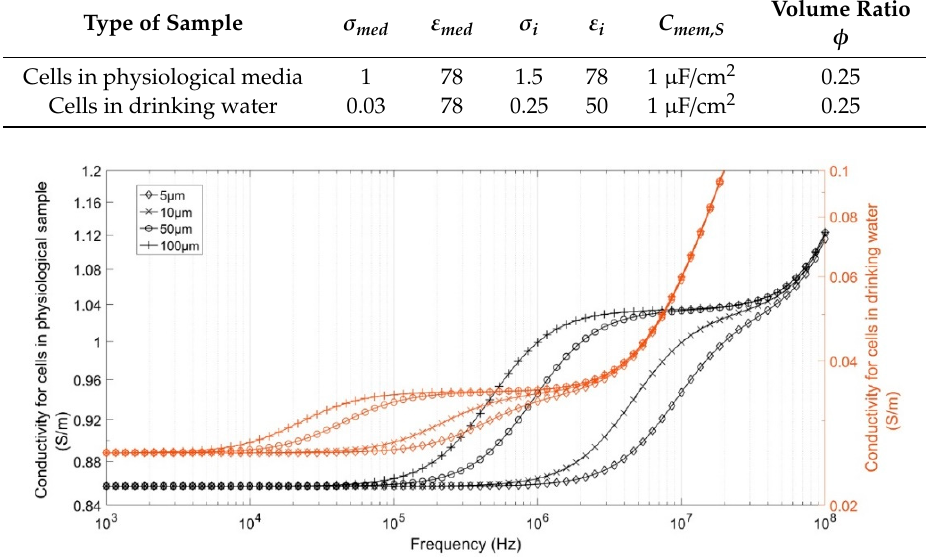
Figure 1. Complex conductivity module of samples versus cell diameter.